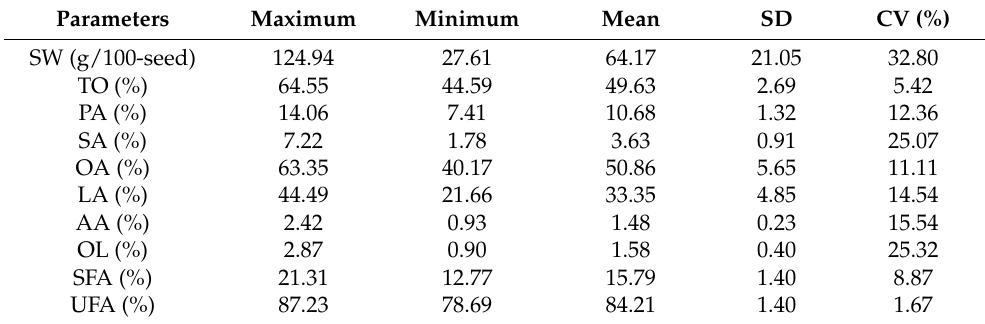
Table 1. Summary statistics of seed weight, total oil content, and individual and total fatty acid contents of the seeds of 301 peanut